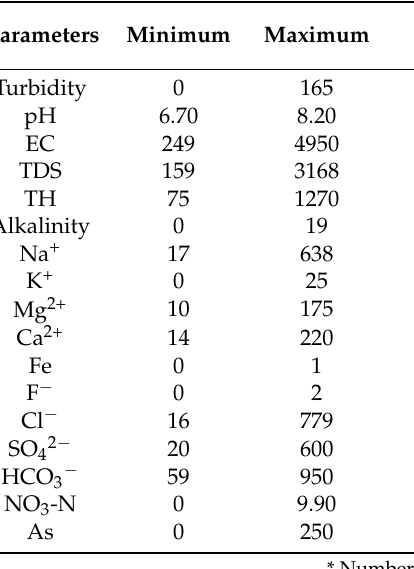
Table 3. Statistical analyses of chemical parameters (units of all parameters are mg/L, except